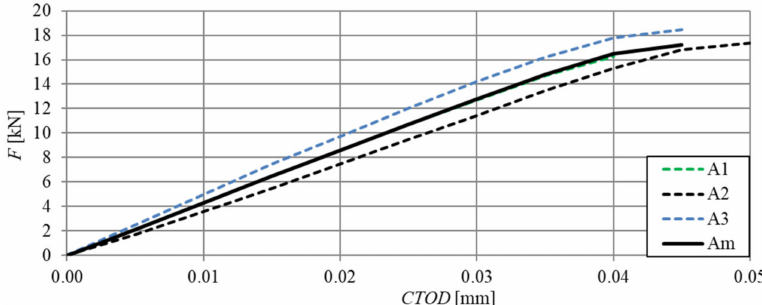
Figure 9. Force-crack tip opening displacement relationships of SFRHSC beams (B and C series).